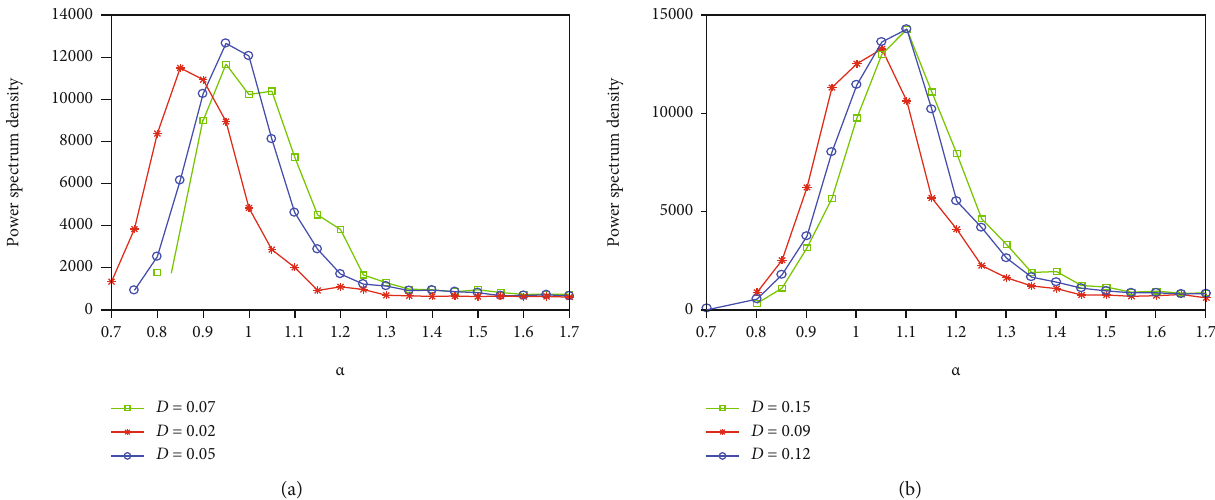
Figure 6: The relationship between characteristic exponent α and system output of undamped bistable system driven by Lévy noise. (a) The output when input is white noise intensity D = 0 : 02 , 0.05, and 0.07. (b) The output when input white noise intensity is D = 0 : 09 , 0.12, and 0.15.